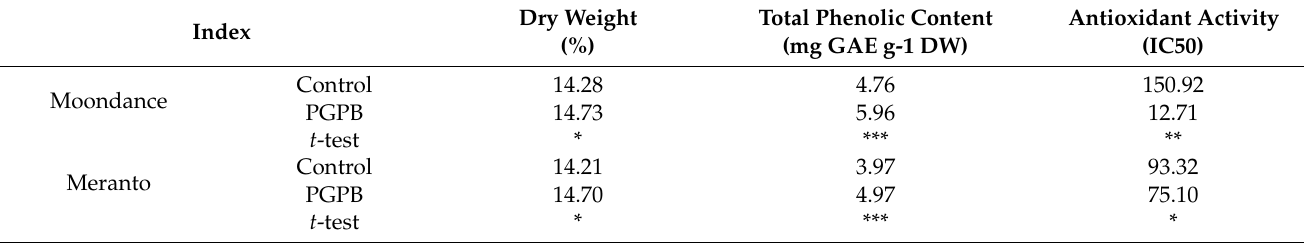
Table 1. Dry weight, total phenolic content, and antioxidant activity of bulbs of Meranto and Moondance cultivars.